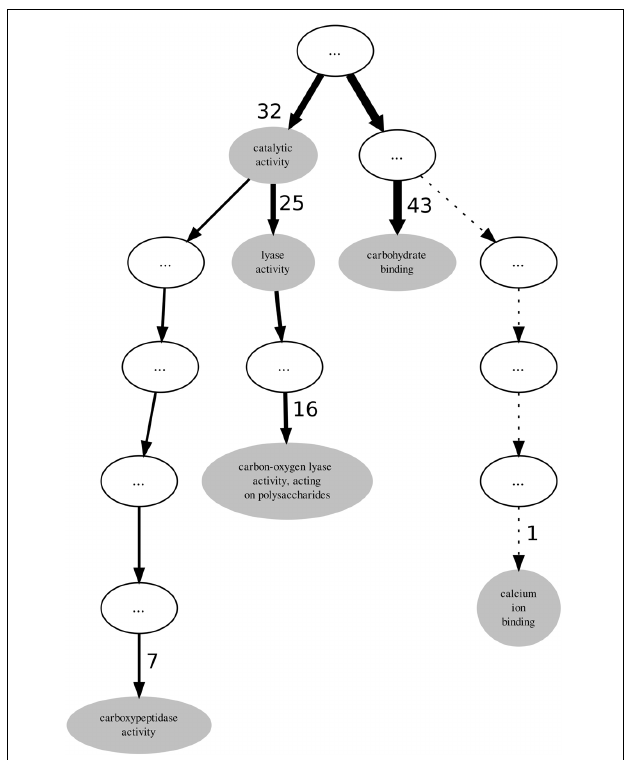
FIGURE 3 | Graph subsuming the GO molecular function aspect annotation of CAZy’s PL4 family.